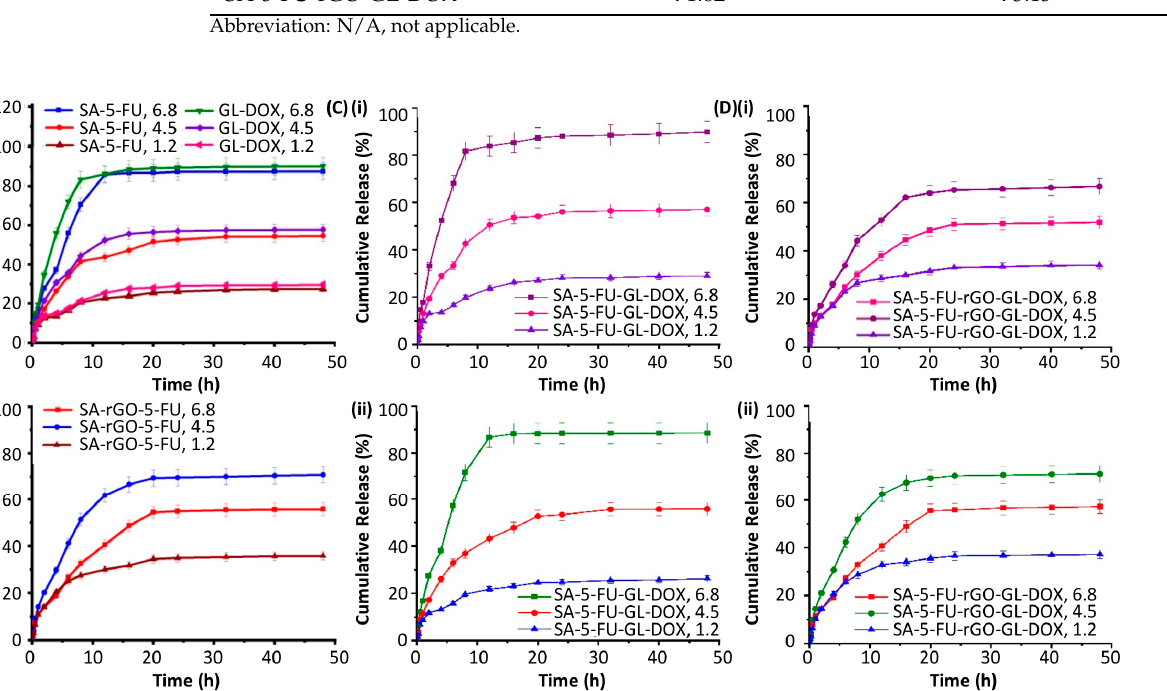
Figure 6. Release profiles of the loaded drug from ( A ) GL-DOX and SA-5-FU and from ( B ) SA-rGO-5-FU in the release medium at different pH values (6.8, 4.5 and 1.2). ( C ) Release profiles of ( i ) DOX and ( ii ) 5-FU from SA-5-FU-GL-DOX in the release medium at different pH values (6.8, 4.5 and 1.2). ( D ) Release profiles of ( i ) DOX and ( ii ) 5-FU from SA-5-FU-rGO-GL-DOX in the release medium at different pH values (6.8, 4.5 and 1.2).